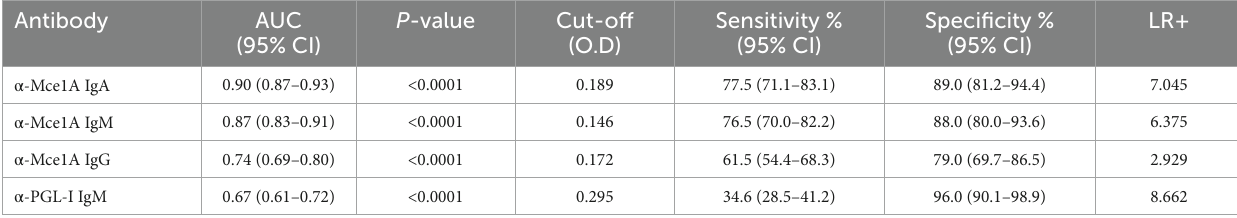
TABLE 2 Comparison of the performance of IgA, IgM, and IgG α -Mce1A protein and IgM α -PGL-I for the diagnosis of new HD Cases ( n = 200).